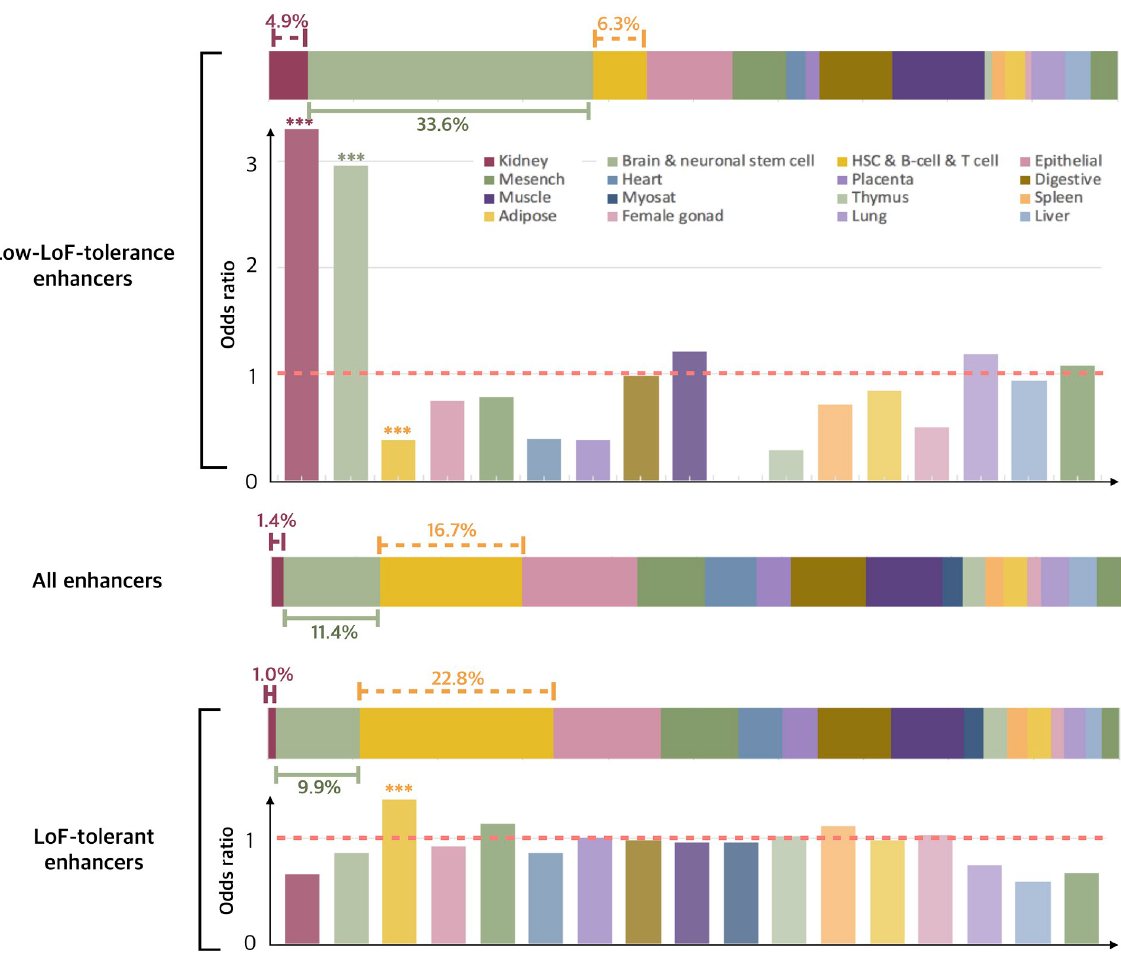
Fig 2. Tissue-specific enhancers. Three horizontal bars separately show the percentage of low-LoF-tolerance, all enhancers and LoF-tolerant enhancers in each tissue type. The matching vertical bar plots show the odds ratios for enrichment of the percentage of low-LoF-tolerance and LoF-tolerant enhancers for each tissue relative to all tissues. (asterisks mark the statistical significance using Fisher’s exact test).